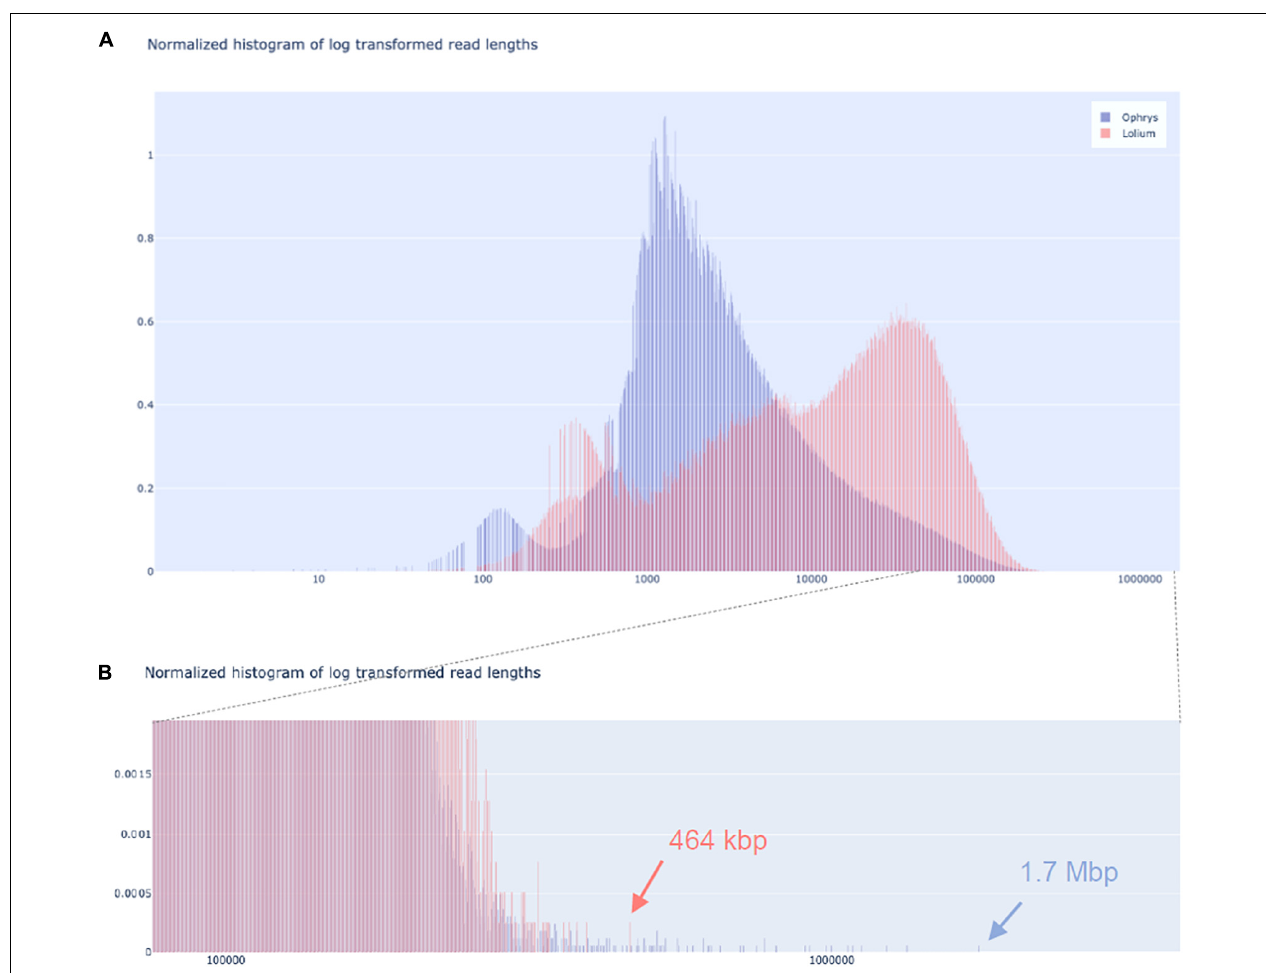
FIGURE 4 | Nanopore sequencing read length distributions. Read length distribution for O. sphegodes OPH_3 (blue; without Circulomics kit) and L. multiflorum RAB_2_Circ (red; after Circulomics kit), showing (A) the entire normalised histogram of log-transformed read lengths and (B) a zoom-in into the section showing the longest reads (OPH_3 = 1.7 Mbp; RAB_2_Circ = 464